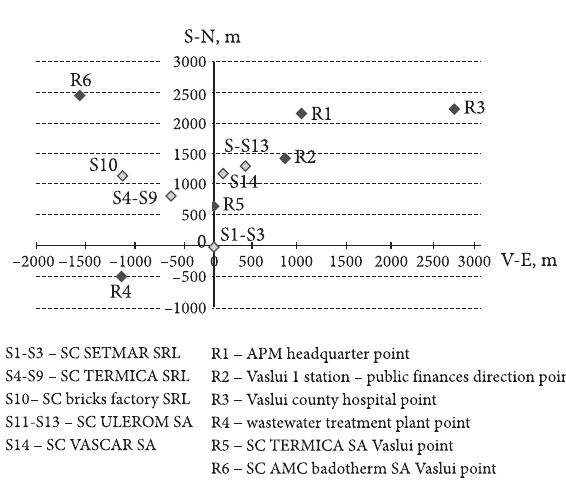
Fig. 1. Scheme for territorial arrangement of multiple sources and industrial receptor – points, by reporting to a fixed reference